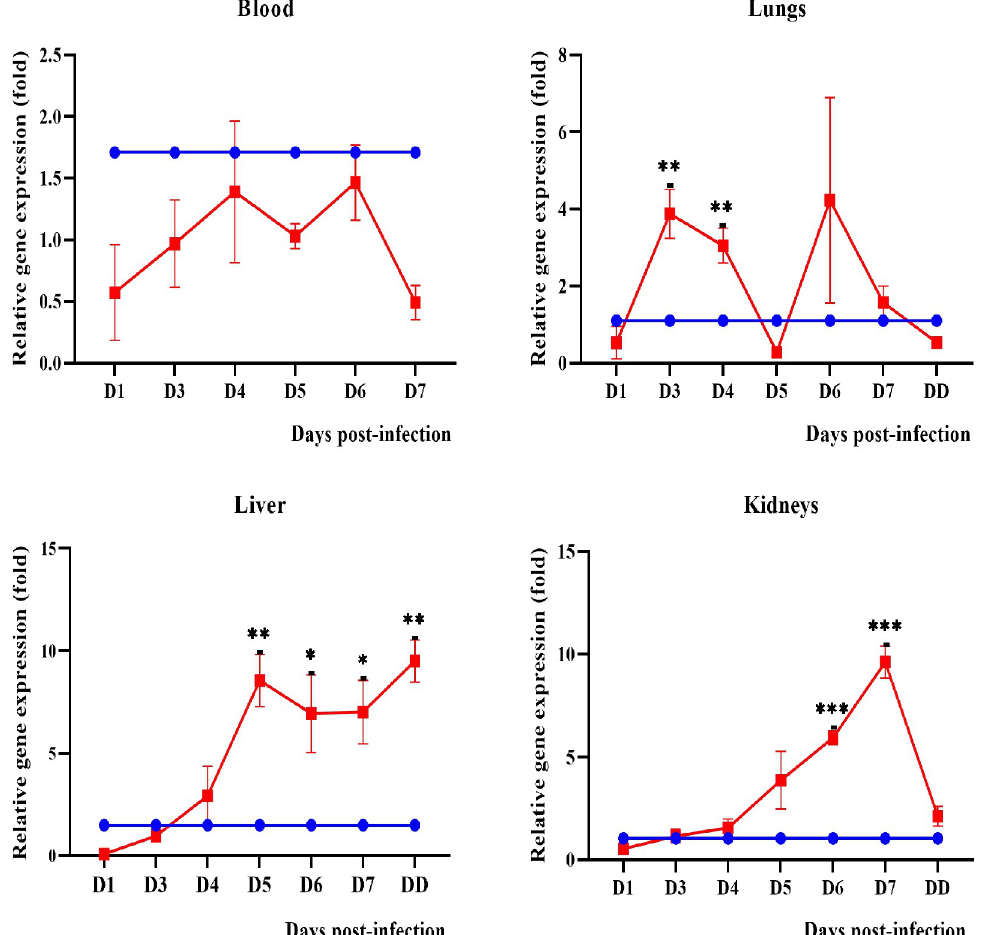
Fig 14. Expression of TGF- β 1 in blood, lungs, liver and kidneys of control (blue line) and infected hamsters (red line). D1-D7:Day 1 to day 7. DD: dead. � P � 0.05, �� P � 0.01, ��� P � 0.001.The fold gene expression value can be found in S4 Table.